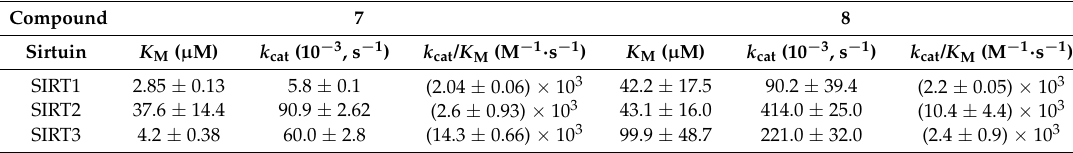
Table 3. The kinetic parameters for compounds 7 / 8 ’s substrate activities with SIRT1/2/3 a . Compound 7 8 Sirtuin